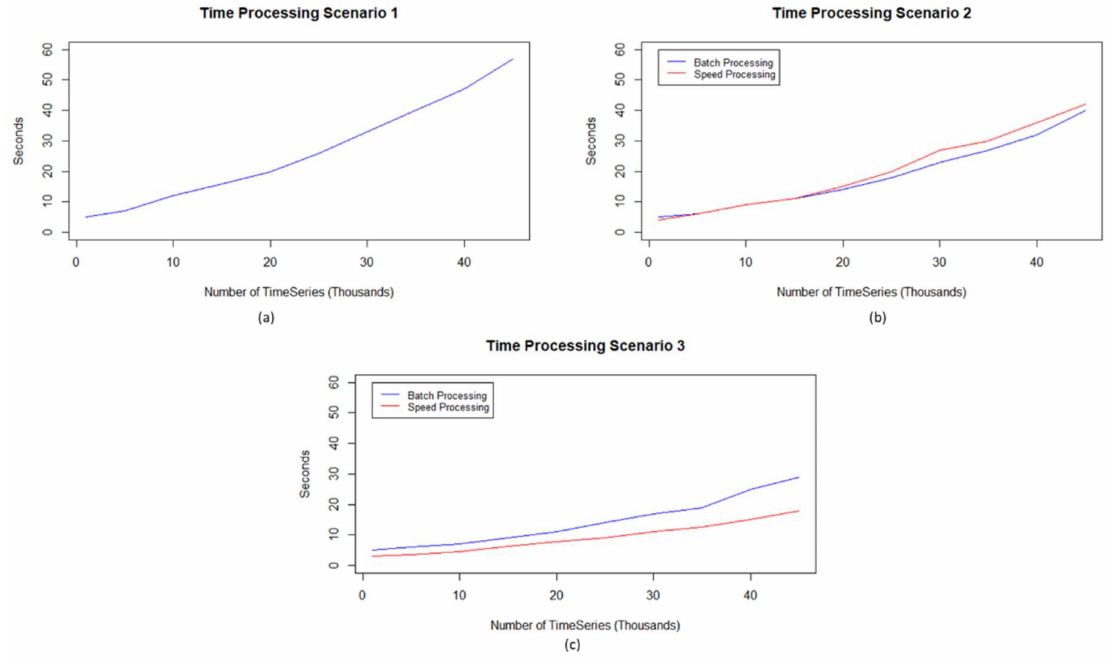
Figure 10. Computation time. ( a ) Time processing scenario 1; ( b ) Time processing scenario 2; ( c ) Time processing scenario